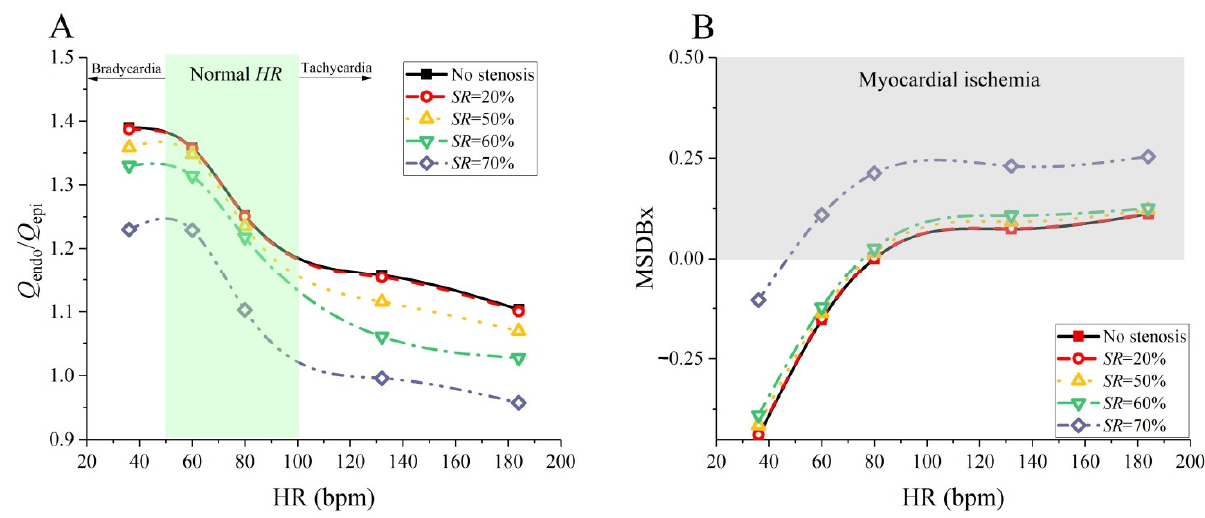
Figure 4. Changes of Q endo / Q epi ( A ) and MSDBx ( B ) with variations in HR in the absence or in the presence of coronary artery stenosis of various severities ( SR = 20~70%). The region highlighted by shadow in panel ( A ) represents the range of physiologically normal HR, and the shadowed area in panel ( B ) denotes the region of myocardial ischemia (i.e., MSDBx > 0).